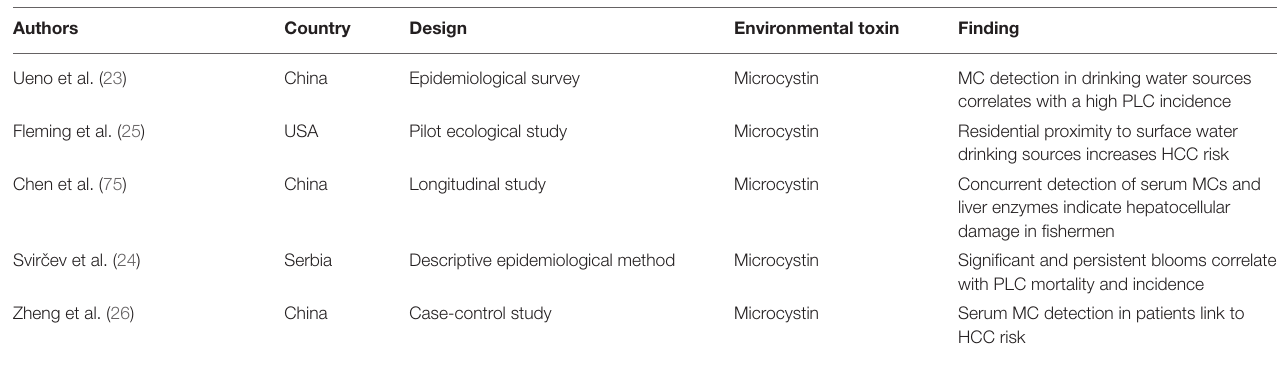
TABLE 1 | Summary of epidemiological investigations on microcystins and liver disease.